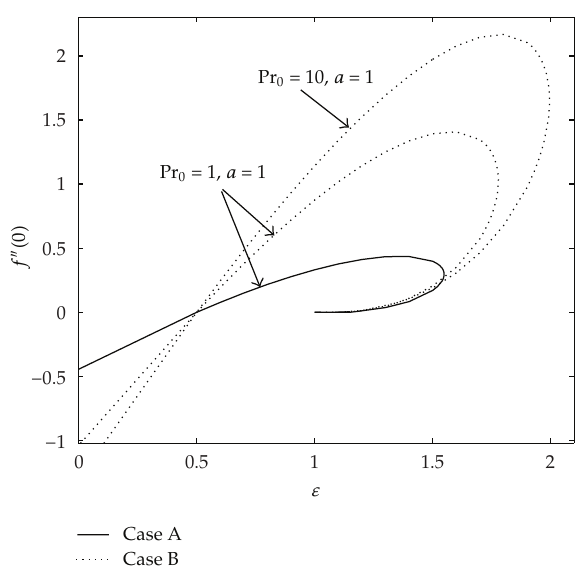
Figure 1: Variation of the reduced skin friction f (cid:4)(cid:4) (cid:5) 0 (cid:6) with ε for di ff erent values of Pr 0 when a (cid:8) 1. Case A (cid:5) solid line (cid:6) : constant viscosity and Case B (cid:5) dotted line (cid:6) : inversely linear viscosity, (cid:5) 3.5 (cid:6) , and (cid:5) 3.6 (cid:6) .